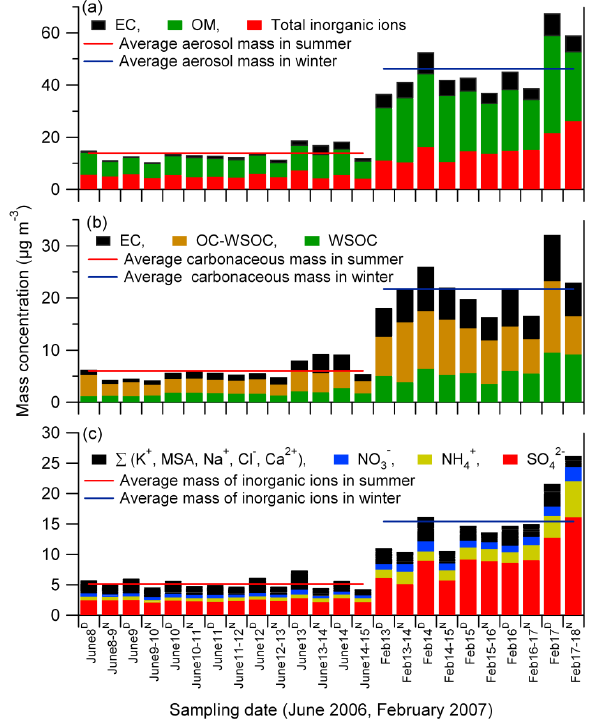
Fig. 2. Temporal variations of aerosol mass loading with the (a) ma- jor component concentrations (where, OM = OC × 1.6), (b) com- position of carbonaceous mass, and (c) inorganic ion